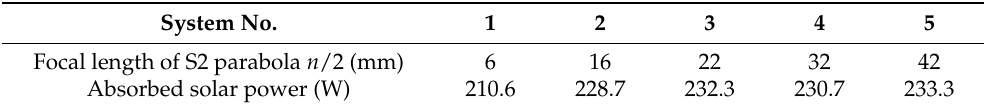
Table 4. Parameters of the parabolic surface S2 and absorbed solar power for the different systems investigated. System